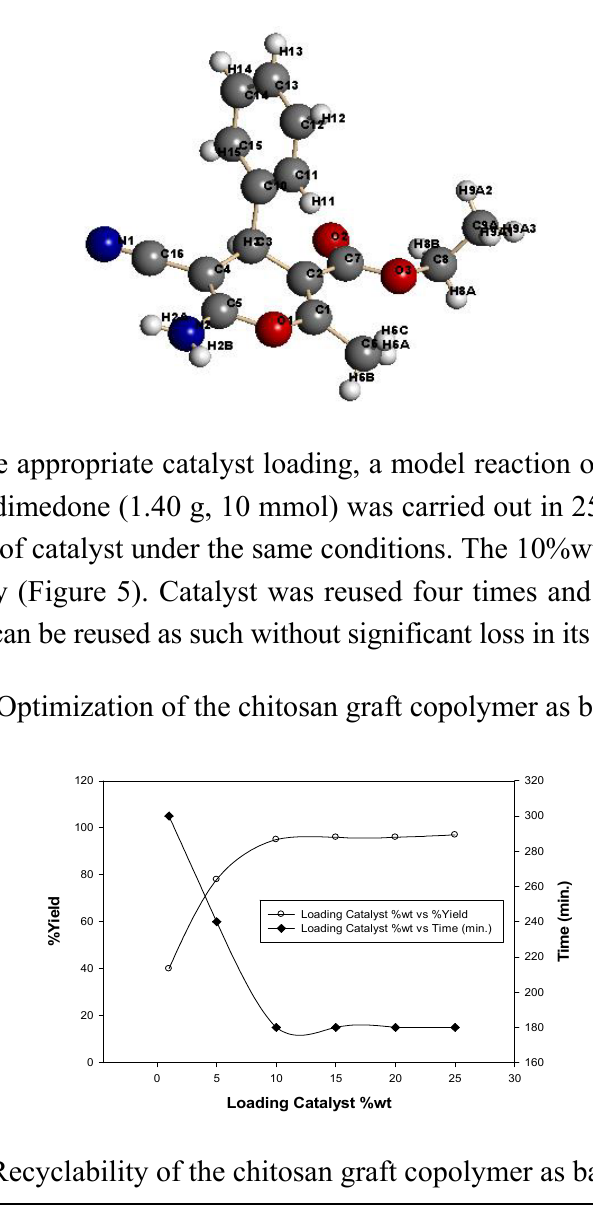
Figure 4. X-ray crystal structure of 2-aminopyran derivative 4 .